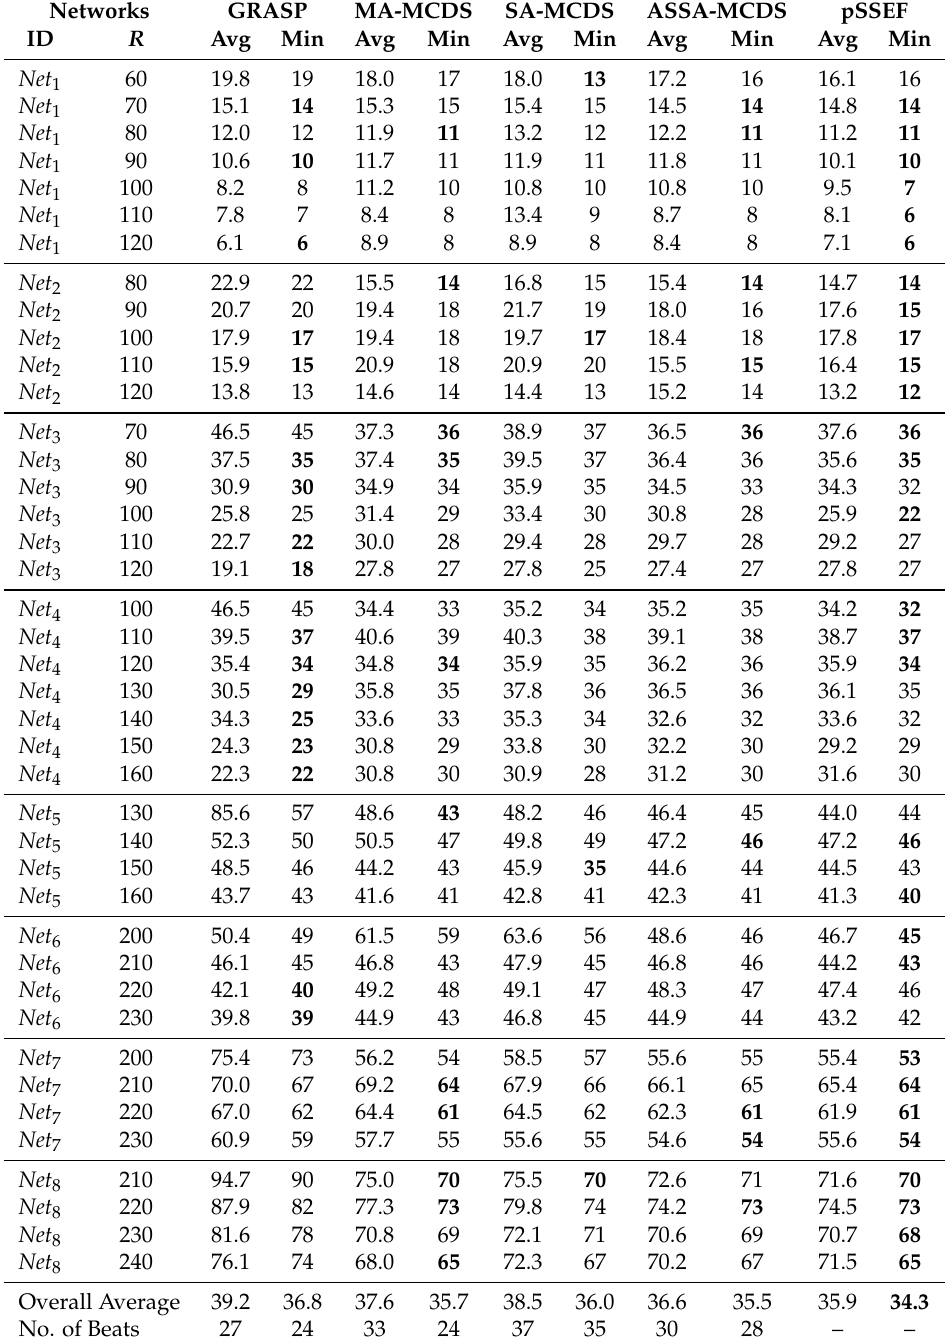
Table 4. Comparison results for network